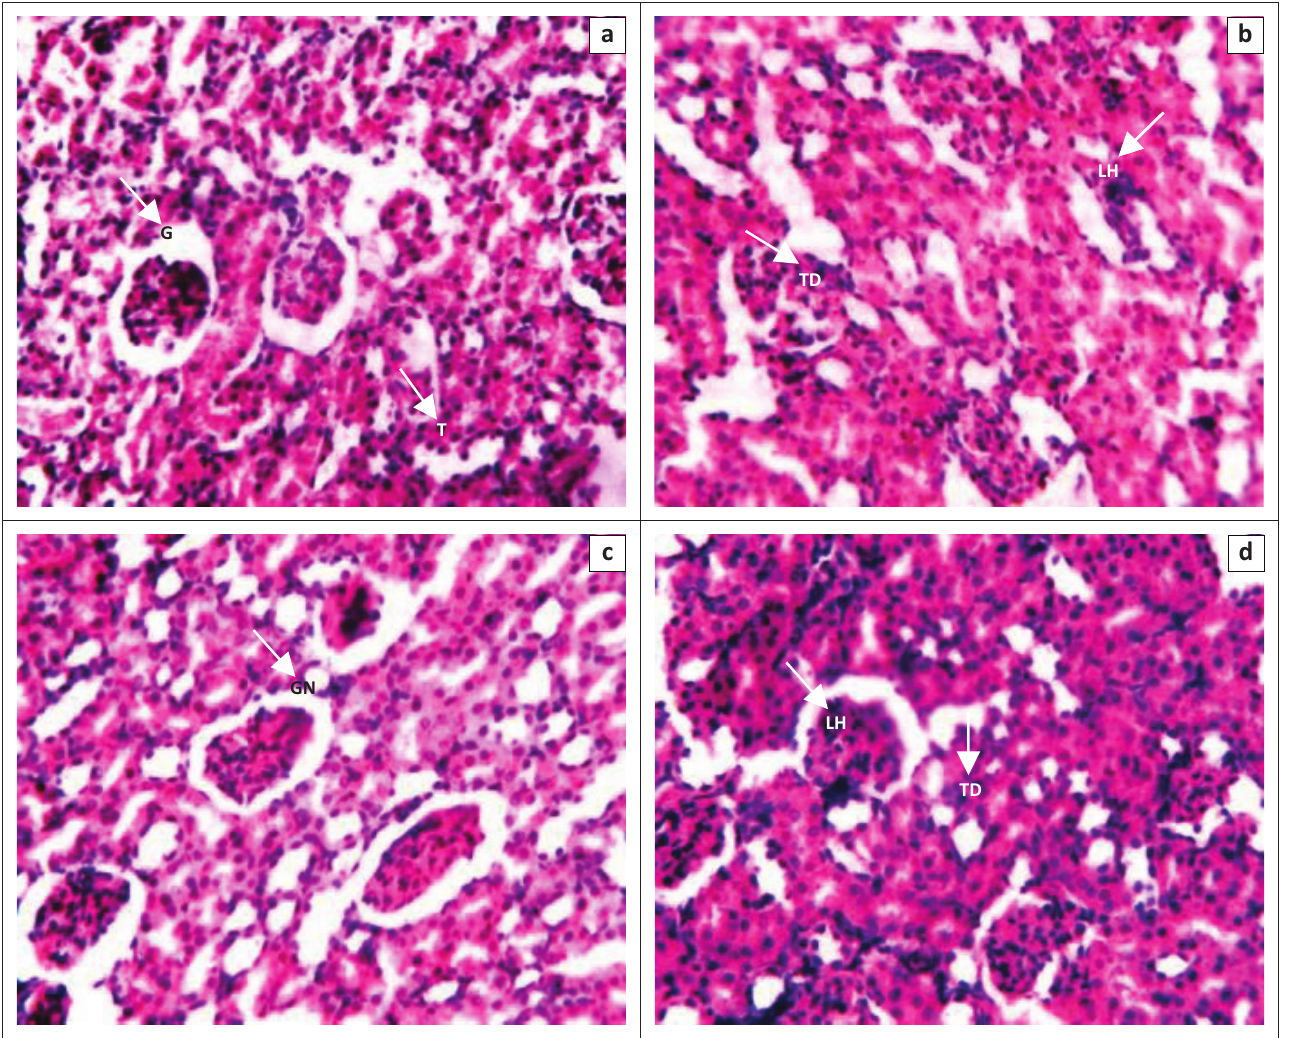
FIGURE 5: Photomicrograph showing the kidney section of (a) control group (1 mL/kg distilled water) shows the normal architecture tubules (T) and glomerulus; (b) treated with 500 mg/kg methanol extract slight tubular distortion and lymphocyte hyperplasia; (c) treated with 1000 mg/kg methanol extract shows slight glomerular necrosis; (d) treated with 1500 mg/kg methanol extract show slight tubular distortion and lymphocyte hyperplasia (haematoxylin and eosin stain; original magnification ×